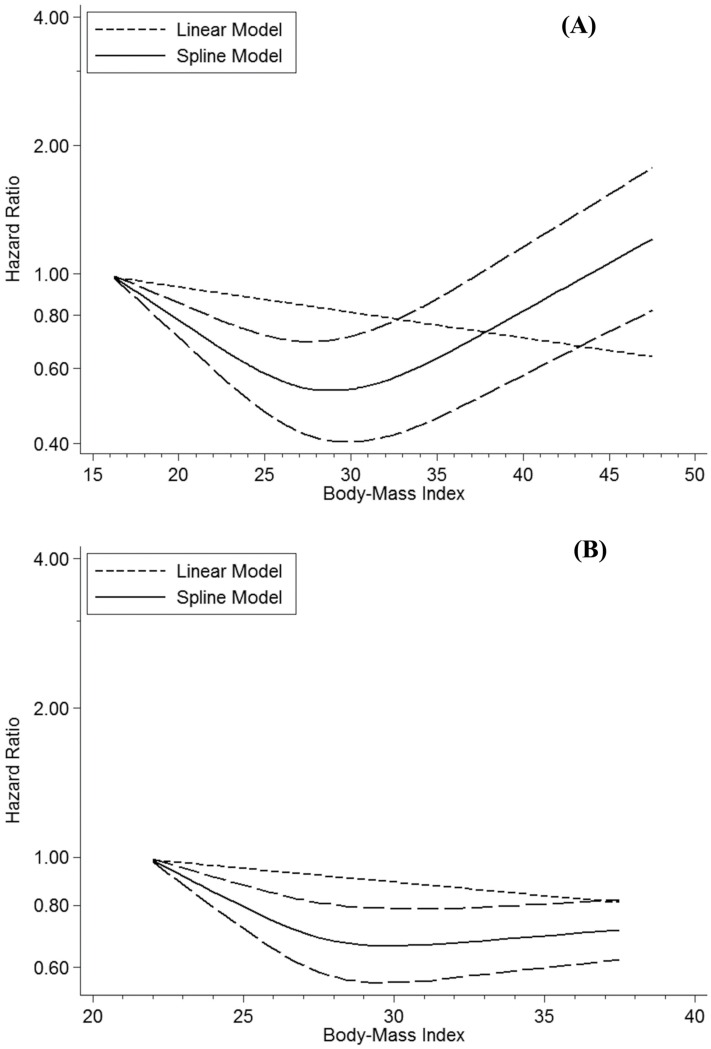
Dose-response associations between body mass index (BMI) and mortality among patients with type 2 diabetes.(A) Non-linear dose-response relationship between BMI and all-cause mortality (P < 0.001). (B) Non-linear dose-response relationship between BMI and cardiovascular mortality (P < 0.001). Non-linear and linear plots are displayed with continuous and medium-dashed black lines, respectively. Long-dashed black lines depict 95% confidence intervals. The log-scale of the hazard ratios are presented on the vertical axes.